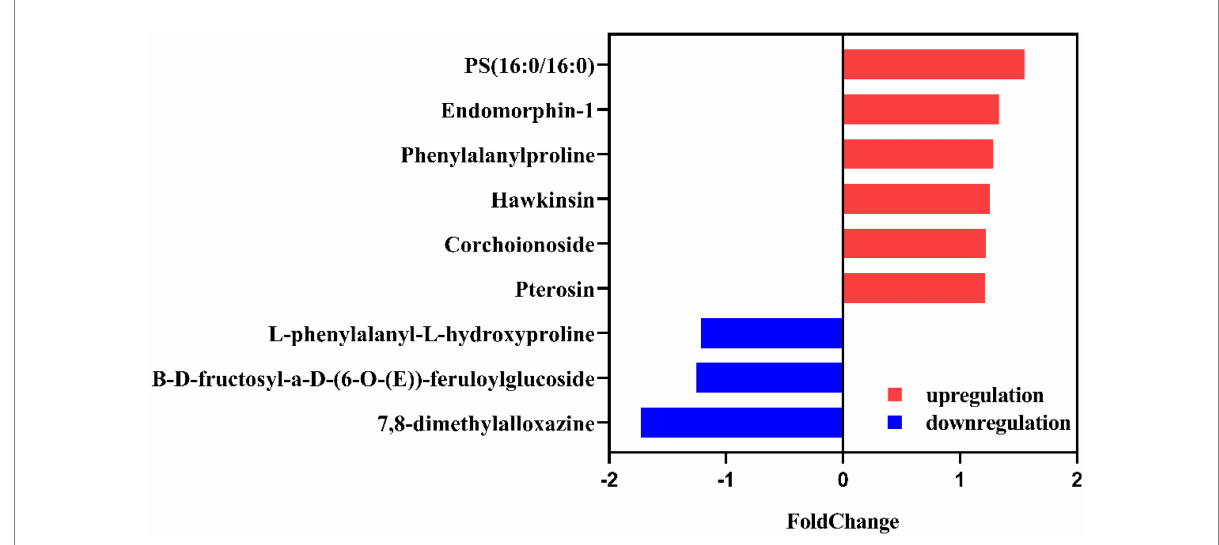
FIGURE 6 Differentially produced metabolites in meropenem-free cultures of K . pneumoiae SW1780 and under sub-MIC levels of meropenem (SW1786 vs. SW1780).